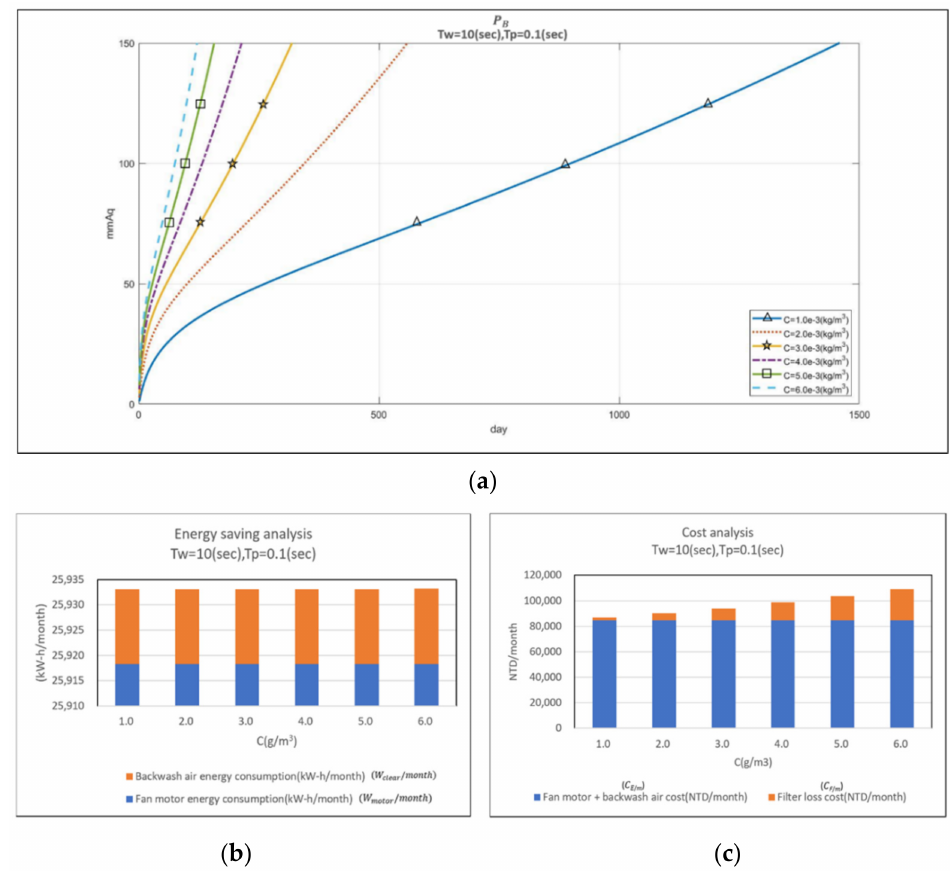
Figure 10. The simulation of energy consumption on different dust concentrations. ( a ). The analysis of the pressure drop. ( b ). The analysis of energy saving. ( c ). The analysis of